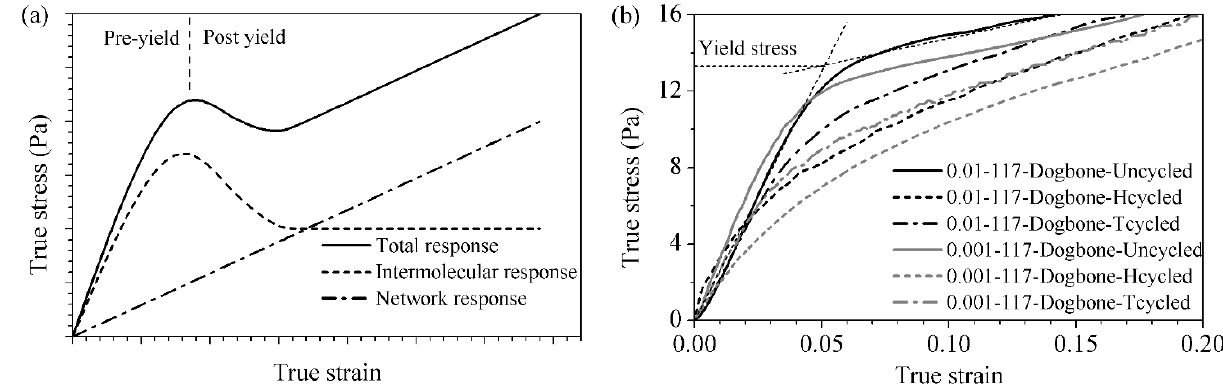
Figure 2. ( a ) True stress-true strain curve of a typical polymer and different zones; ( b ) The true stress-true strain curves of N117 dog-bone tensile test under different strain rates (0.01 s −1 and 0.001 s −1 ) and different cycling